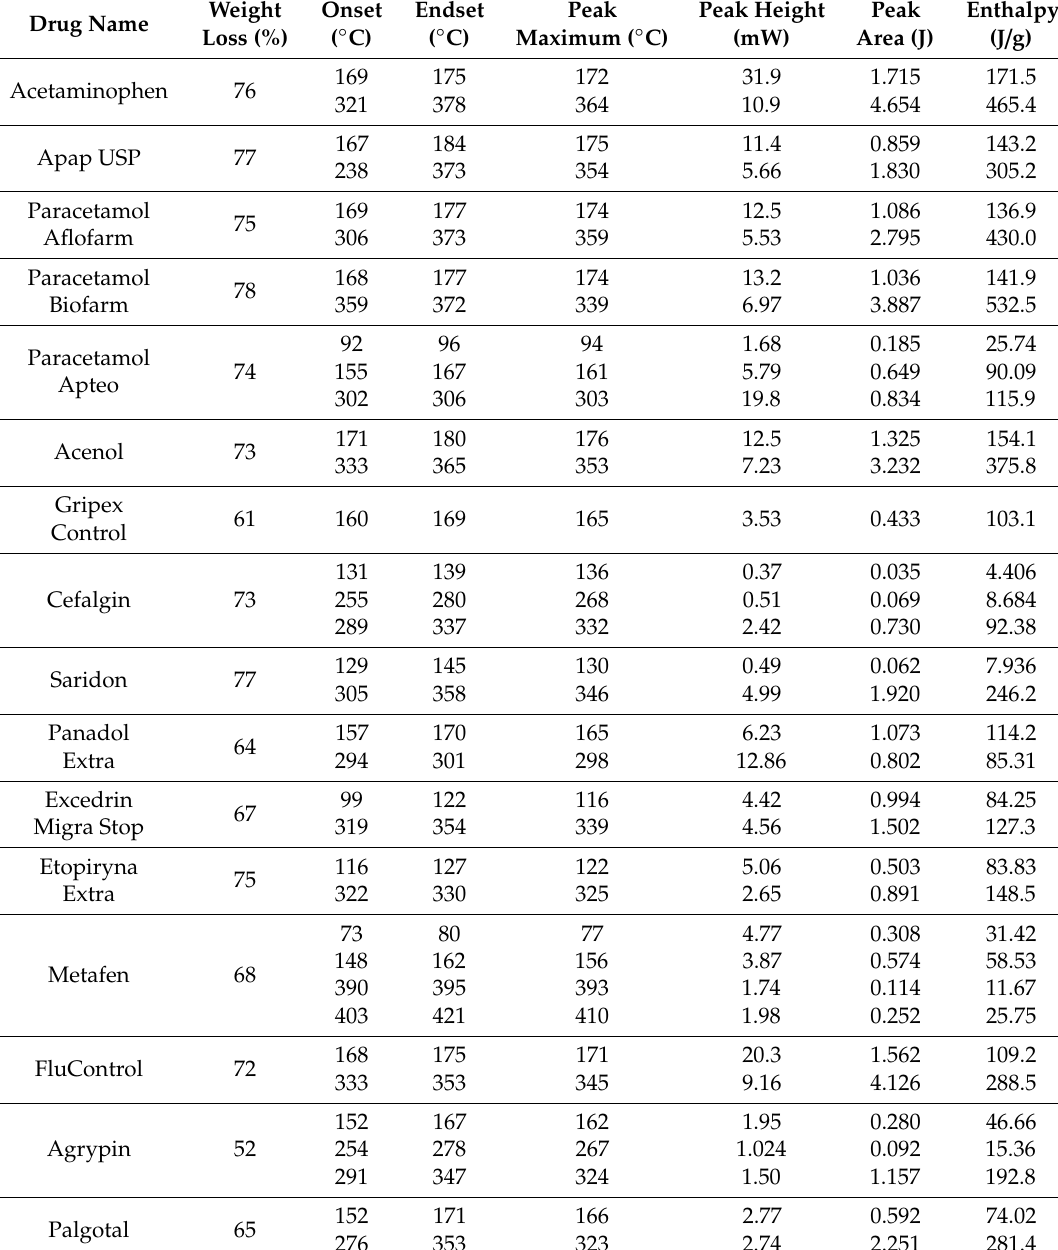
Table 9. Parameters determined from TGA and DSC analysis for pure ACP and investigated